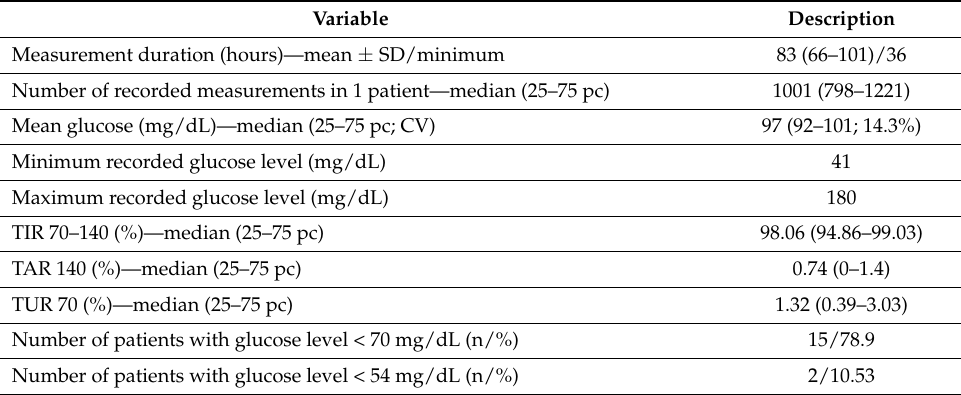
Table 3. Continuous glucose monitoring results (n = 19).